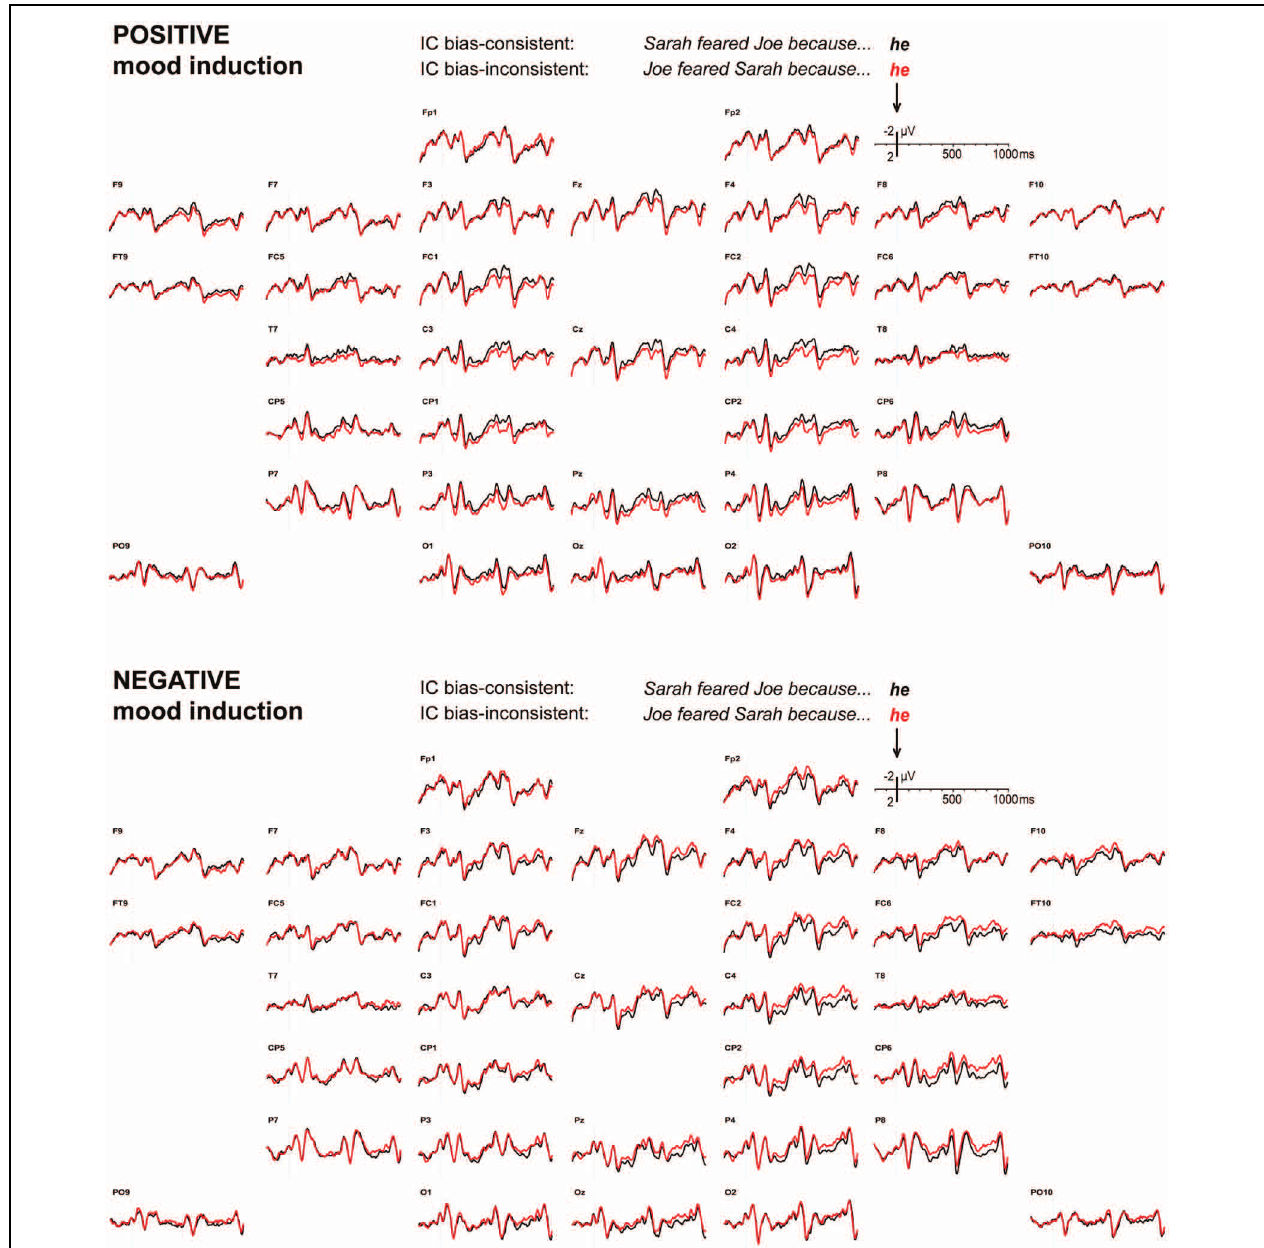
FIGURE 1 | Implicit causality. ERPs to pronouns that are consistent (black) or inconsistent (red) with the implicit causality bias of a preceding verb, after positive (top) or negative (bottom) mood induction. Signals are arranged quasi-topographically, with negative voltage up and onset of the pronoun at